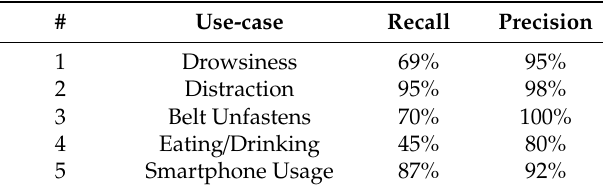
Table 3. Developed framework